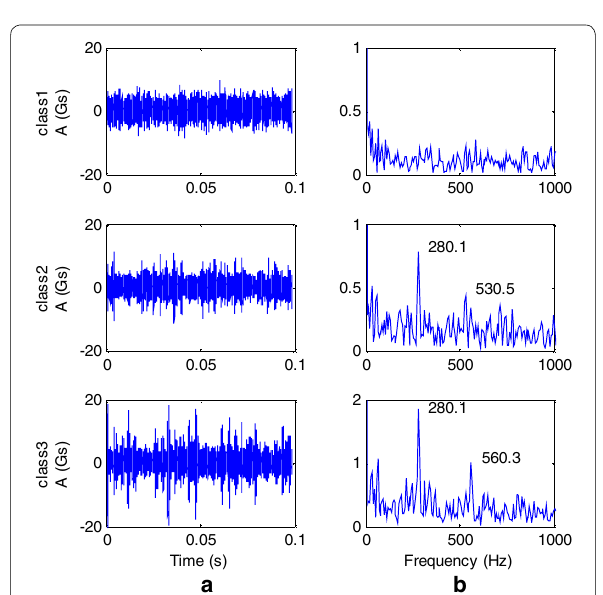
Figure 15 Waveform and IMF1 Hilbert envelope of three classes: ( a ) Waveform, ( b ) Hilbert envelope